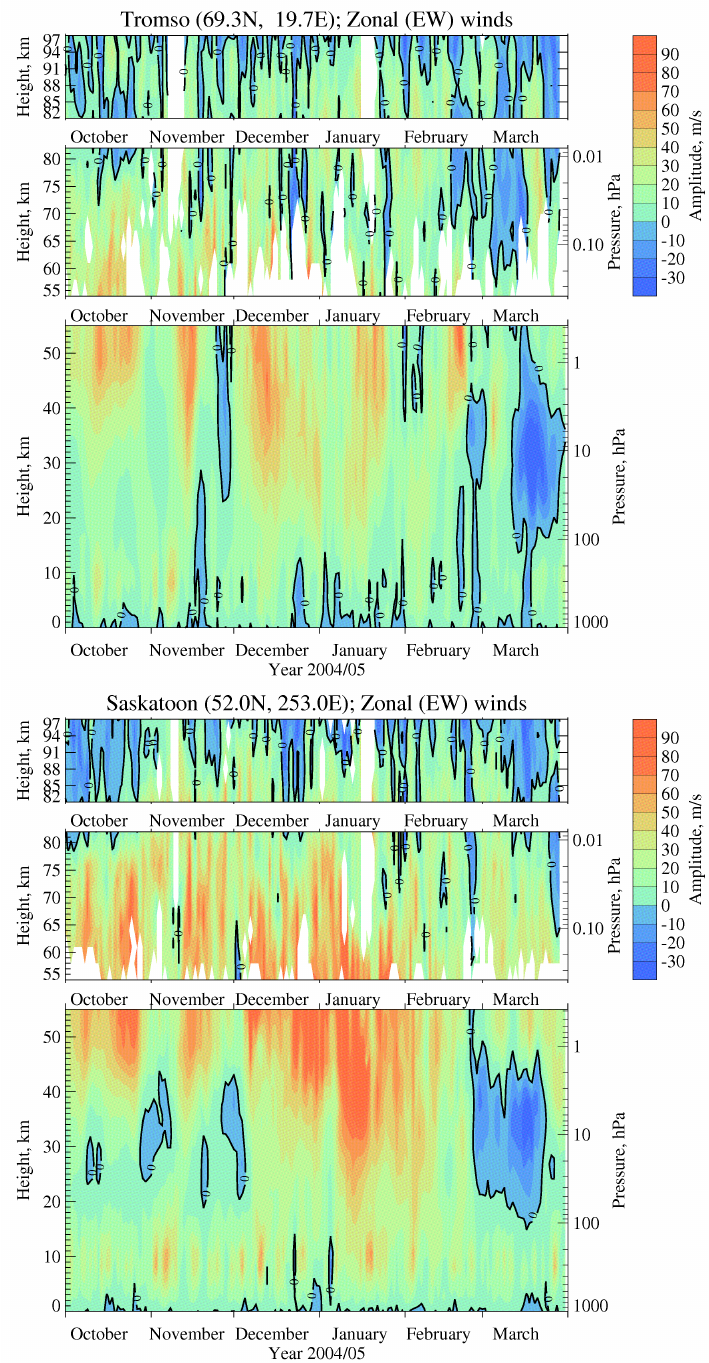
Fig. 7. Evolution of zonal winds in the height range from the surface of the Earth up to the upper mesosphere (97km) in the time interval from October of 2004 until March of 2005 for Tromsø and Saskatoon. The MetO daily winds are shown in the bottom panel of each plot (0–55km), while in the middle (55–82 km) and the top (82–97km) panels day-time mean ( ≥ 7h of data) centred on noon and obtained from radar measurements are